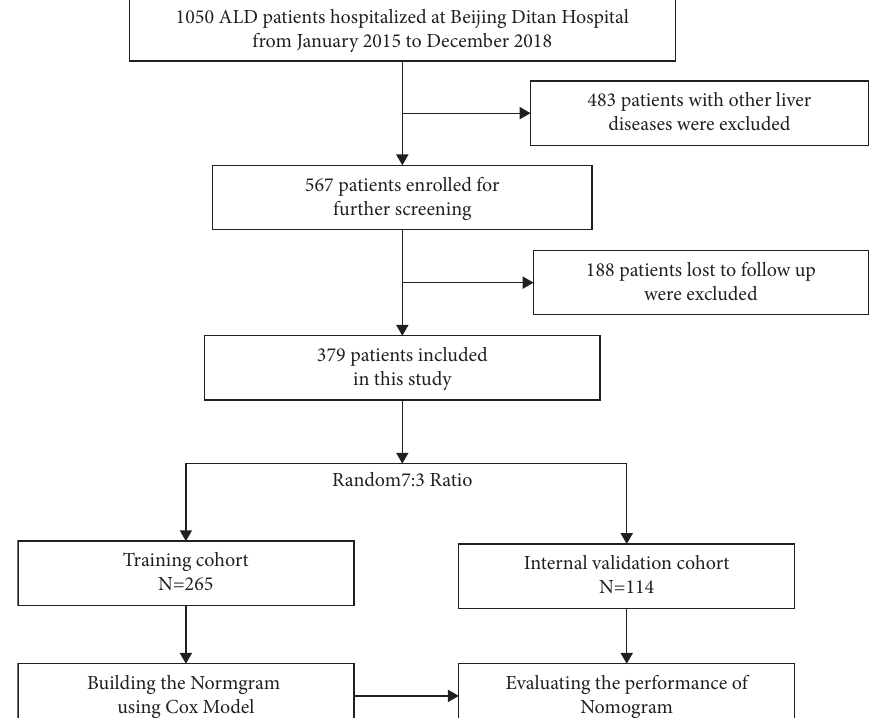
Figure 1: Flowchart of the study’s